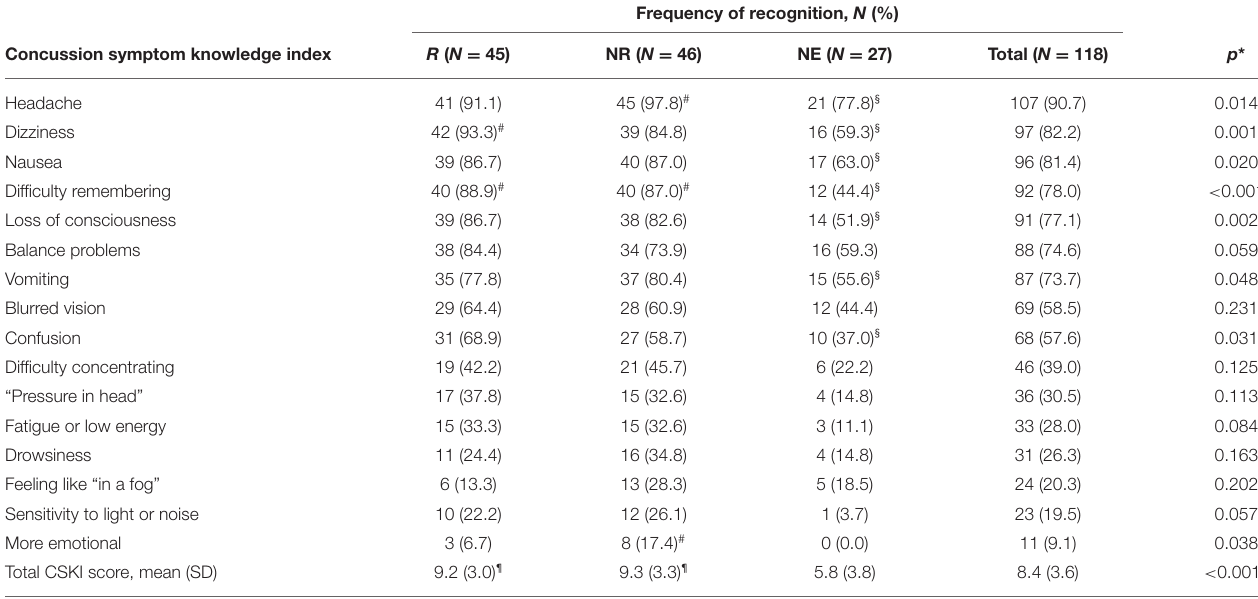
TABLE 1 | Recognition rate of symptoms of suspected